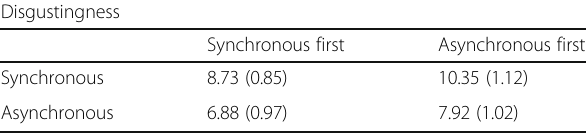
Table 6 The effect of order of presentation